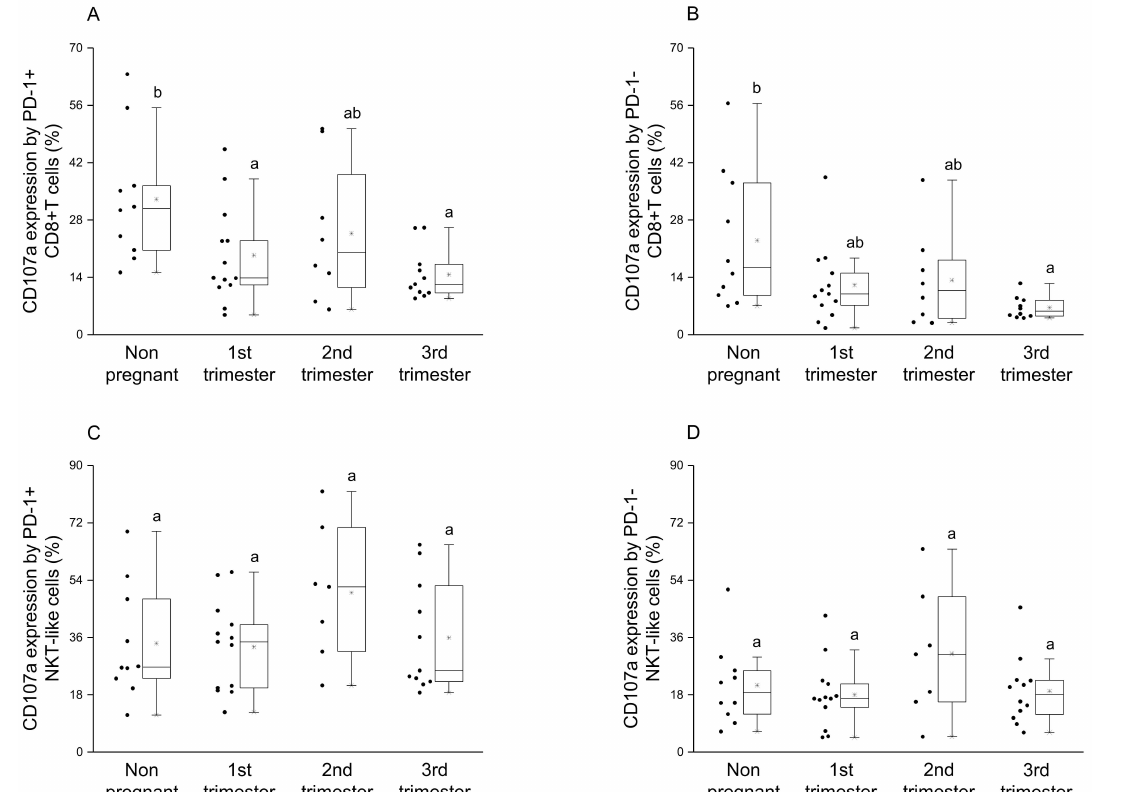
Figure 6. Cytotoxic activity of peripheral PD-1 positive and negative CD8 + T cells and NKT-like cells throughout pregnancy and in nonpregnant women. The expression of CD107a molecule by PD-1 positive ( A ), PD-1 negative ( B ) CD8 + T cells and PD-1 positive ( C ), PD-1 negative ( D ) NKT-like cells. The solid bars represent medians of 10, 13, 10 and 12 samples, respectively, the boxes indicate the interquartile ranges and the lines show the most extreme observations. Di ff erences were considered statistically significant for p -values ≤ 0.05. Variables with the same letter indicate no statistically significant di ff erence, while di ff erent letters indicate a statistically significant di ff erence. Linear regression of CD107a expression by PD-1 and NKG2D positive / negative subpopulations in CD8 + T and NKT-like